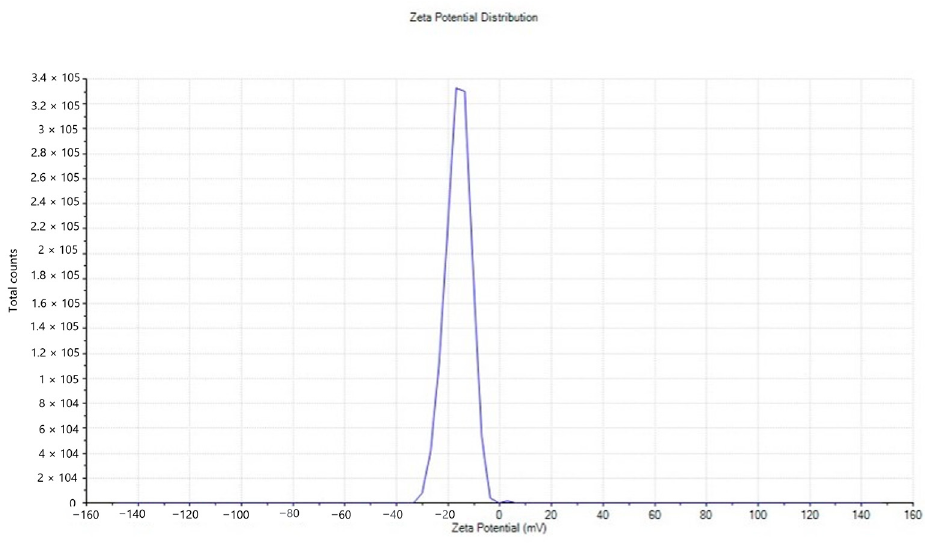
Figure 6. Zeta potential distribution of ZnO NPs.